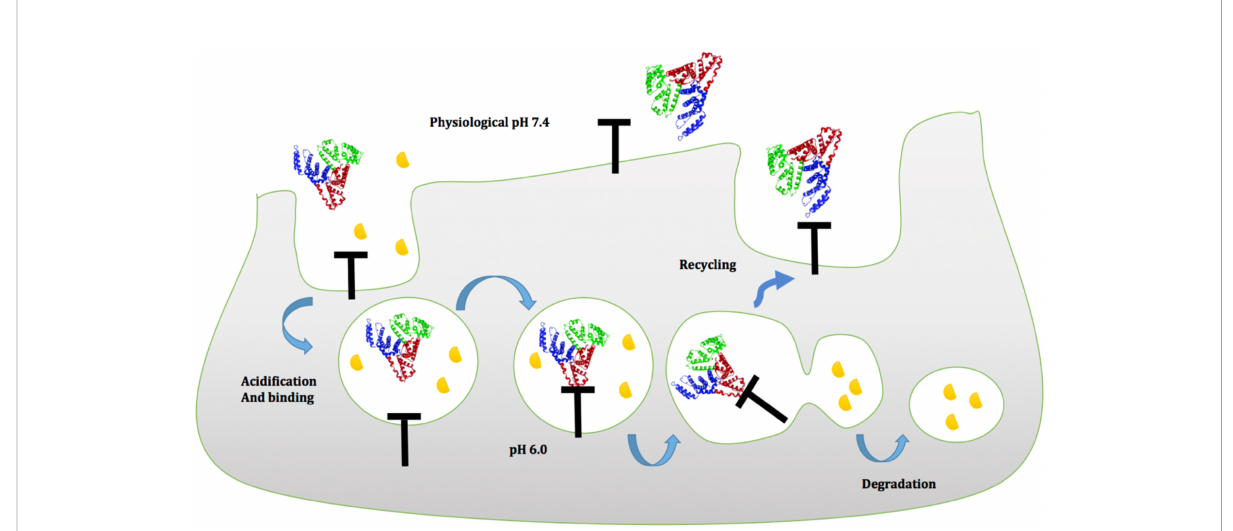
FIGURE 5 Proposed model of albumin to FcRn in a pH-dependent manner at the cell membrane. Green (domain I), blue (domain II), and red (domain III) indicate the three domains of albumin. Domain III albumin binds to the FcRn receptor at an acidic pH of 6.0, protecting it from lysosomal destruction, and then recycles to the blood circulation, where it is released when exposed to physiological pH